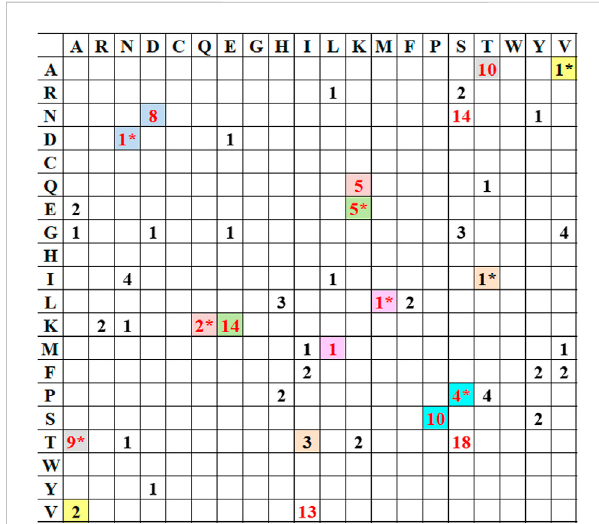
FIGURE 1 Frequency distribution of conceivable mutations (in numeric) empirically observed with HA Ind strains compared with the reference HA Cal strain. Similar colors in the plot depict similar mutations, but the order of mutation from one residue to another is differentiated with “ *.